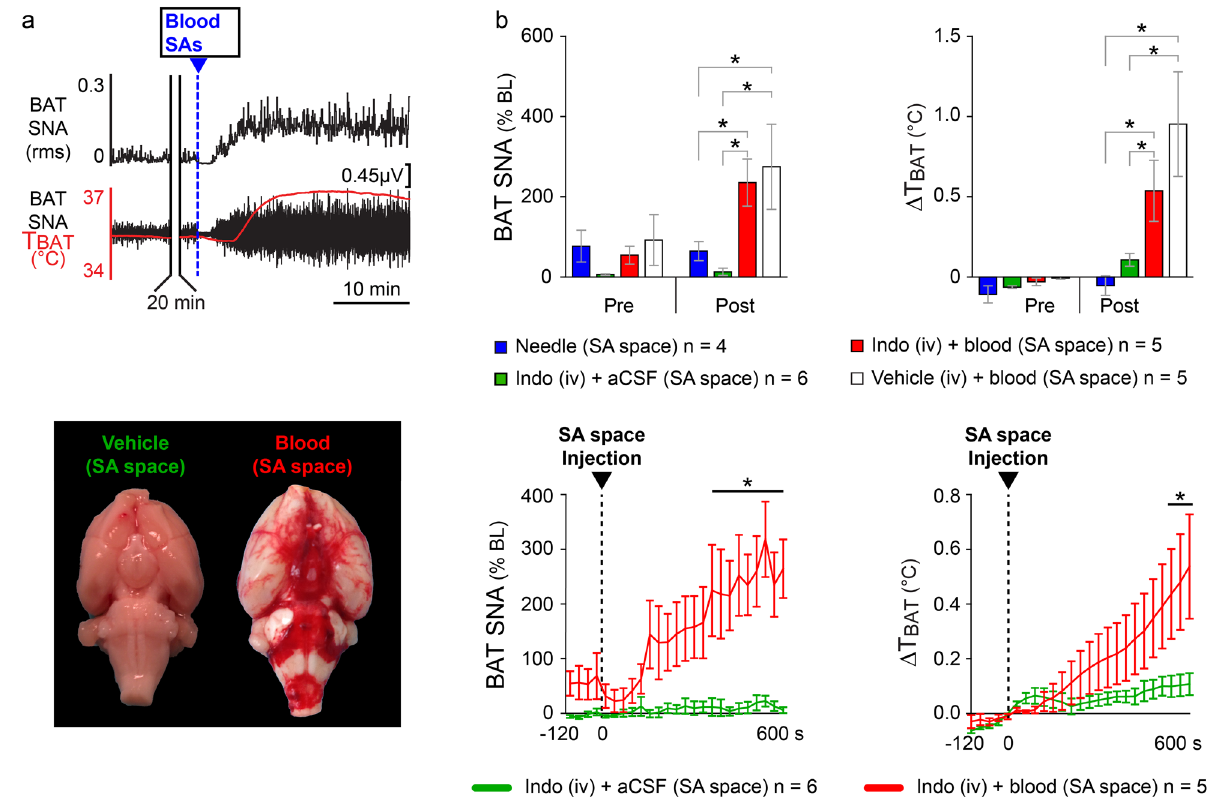
Figure 2. Pretreatment with indomethacin does not prevent the increases in BAT SNA and BAT thermogenesis induced by direct injection of blood into the SA space. ( a ) Top panel: responses in BAT SNA and T BAT elicited by the injection of blood in the SA space of a rat pretreated with indomethacin. The injection of blood produced a prompt increase in BAT SNA and BAT thermogenesis (increase in T BAT ). Lower panel: extravascular blood following the injection of blood into the SA space (right brain) compared with the ventral surface of the brain of a rat injected with vehicle into the SA space (left brain). ( b ) Top panels: group data showing the effects on BAT SNA and BAT thermogenesis (T BAT ) resulting from insertion of the injection needle into the SA space (blue bars); injection of aCSF into the SA space after indomethacin (iv) pretreatment (green bars); injection of blood into the SA space after indomethacin (iv) pretreatment (red bars); or injection of blood in rats pretreated with saline vehicle (iv) (white bars). Bottom panels: time courses of the effects on BAT SNA and T BAT following the injection of either blood or aCSF into the SA space. *p <